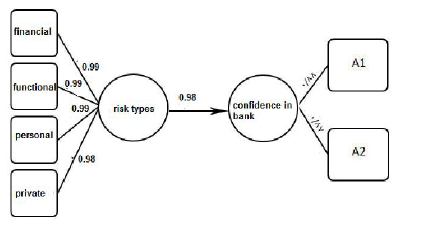
Fig. 8. The results of testing the sixth hypothesis Fig. 9. The results of testing the seventh hypothesis